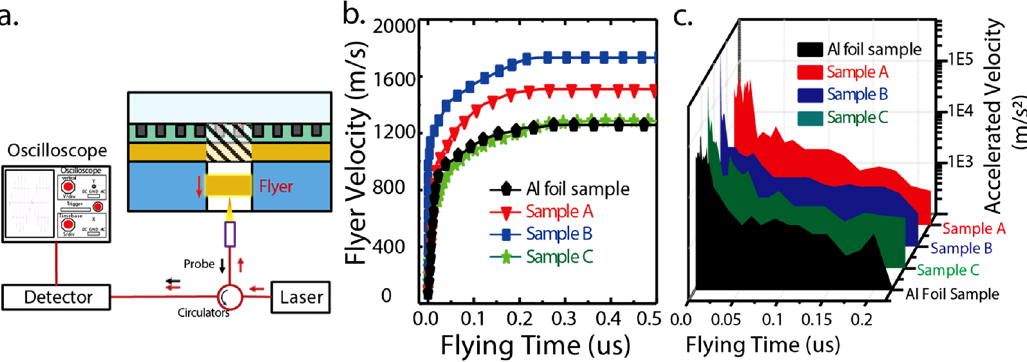
Figure 5: (a) The velocity measurement schematic diagram of the APA-AAO enhanced flyers, where a photonic Doppler velocimetry method is used. The detection light signal is collected by an optical fiber located on the end of the accelerated chamber and then transferred to the oscillographforfurtheranalysis;(b)and(c)themeasuredvelocityandacceleratedvelocityofthe fl yersfromtheAlfoilsample(green),Sample A (red), B (blue), and C (yellow) at different times.